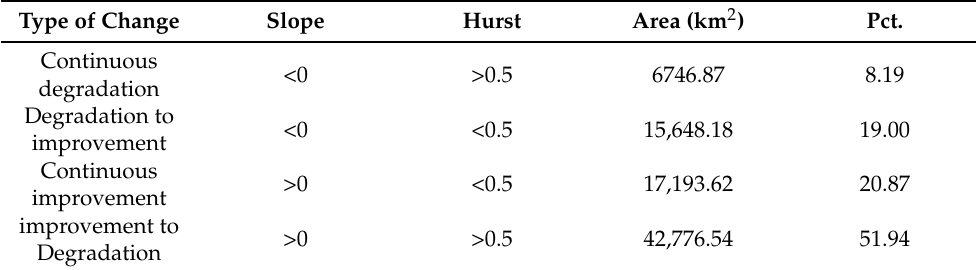
Table 6. Analysis of the trends obtained from long RSEI time series from